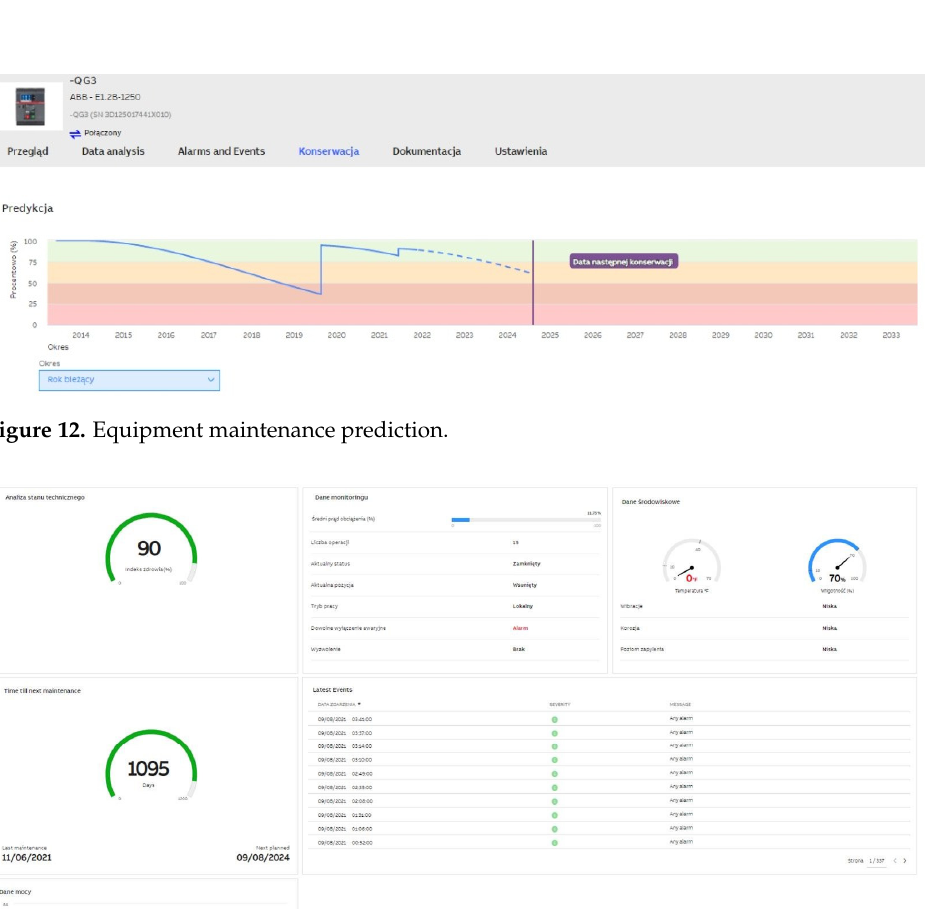
Figure 13. Visualization of the technical condition and parameters of the main switch in the LV switchgear.